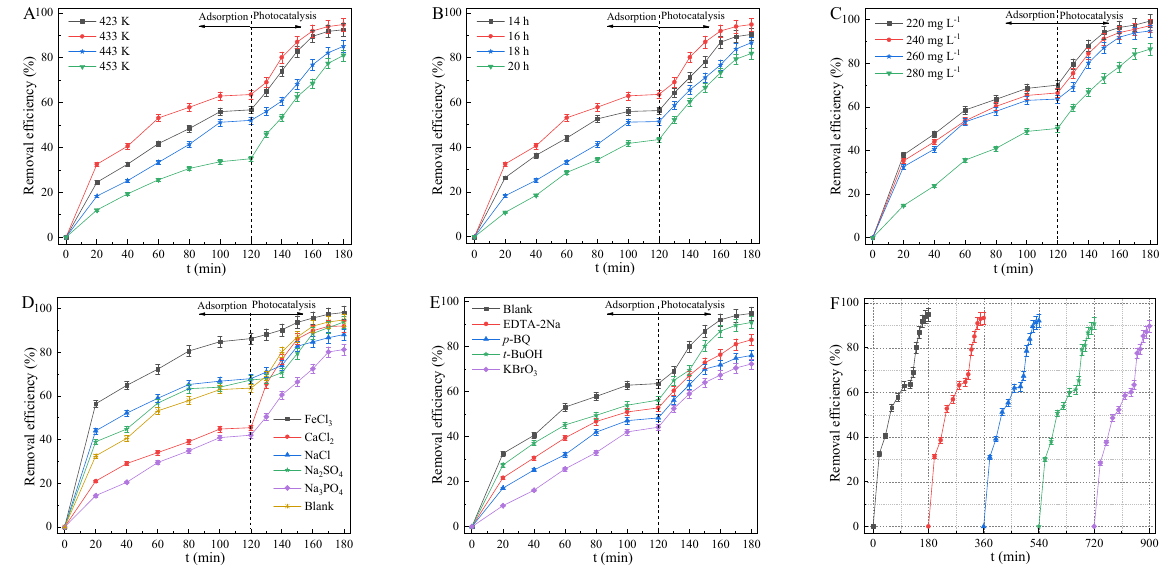
Figure 6. Effects of hydrothermal temperature ( A ), time ( B ), TCH concentration ( C ), inorganic salts ( D ), and quenchers ( E ) on the adsorption-photocatalytic activity of MnS, and durability of MnS ( F ) for TCH removal.